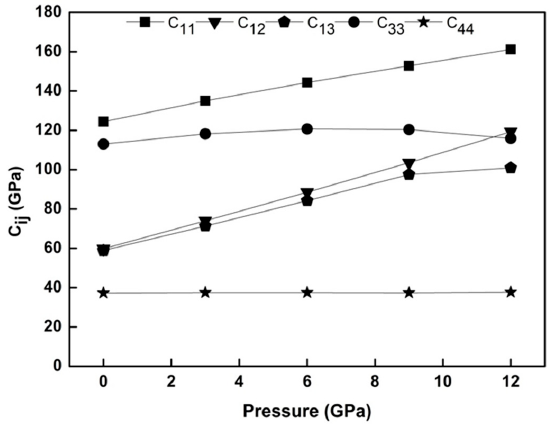
Figure 2. Elastic constants of WZ ZnS under pressure. Table 2. Comparing our results with previous experimental and theoretical data for the considered parameters of WZ ZnS under zero pressure and temperature. * Bulk modulus experimental value was taken from Reference [30].